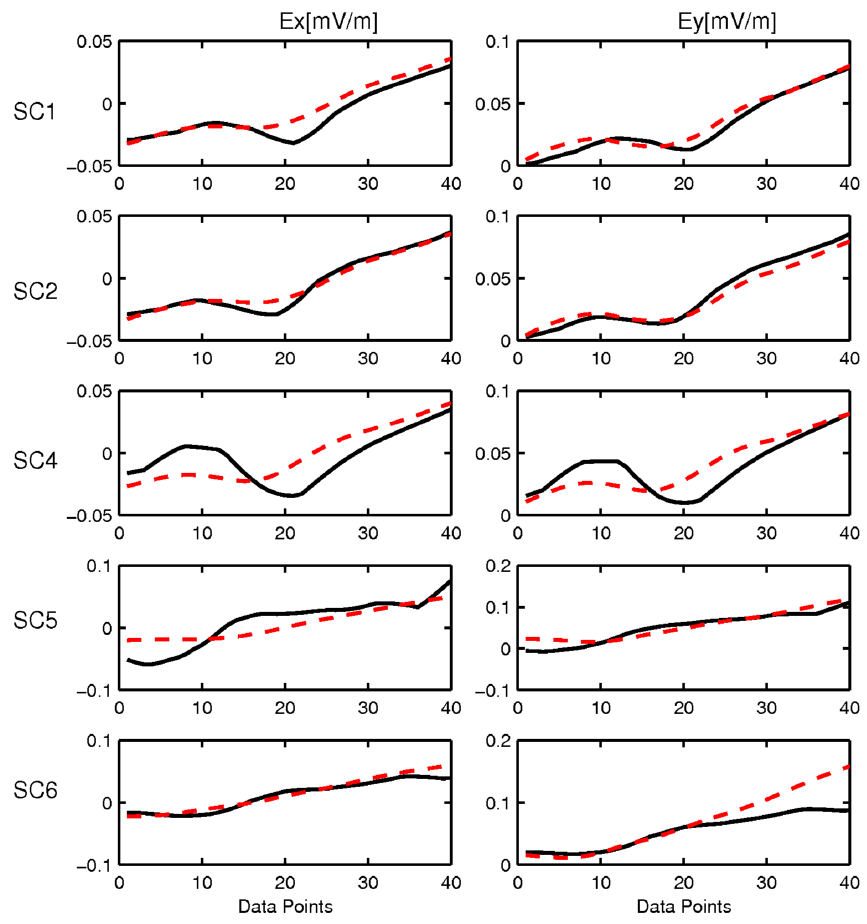
Figure 8. Snapshot plots of the predicted electric fields (red dashed lines) from the reconstruction map based on spacecraft 3 and the corresponding fields (black lines) taken by the other spacecraft directly from the simulation.